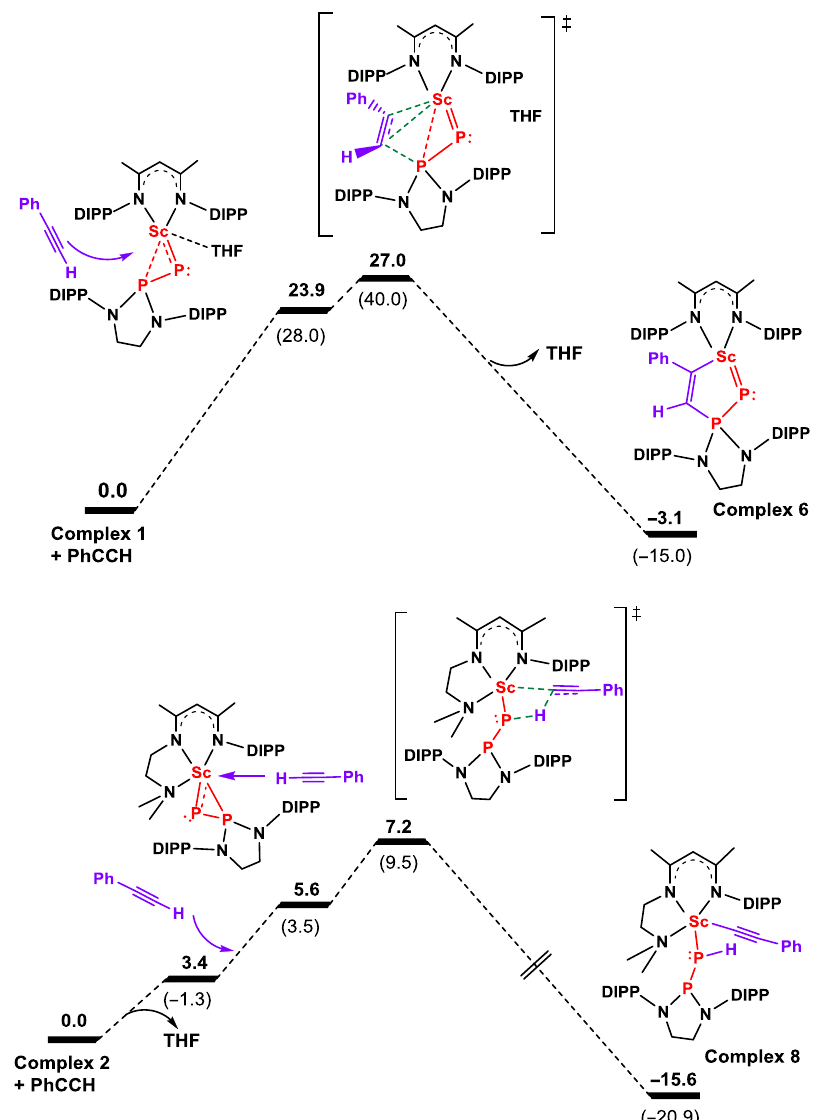
Fig. 6 Computed enthalpy pro fi les (in kcal mol − 1 ). The reactions of phenylacetylene with complexes 1 and 2 provide complexes 6 and 8 , respectively. The values in brackets are the Gibbs free